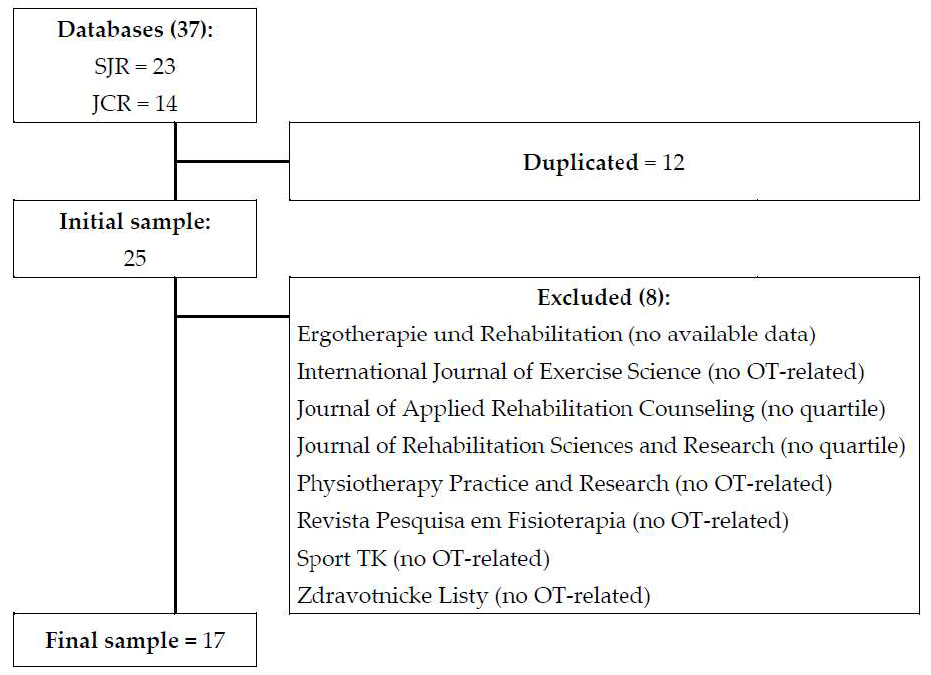
Figure 1. Flow diagram. SJR: Scimago Journal and Country Rank; JCR: Journal Citation Reports .